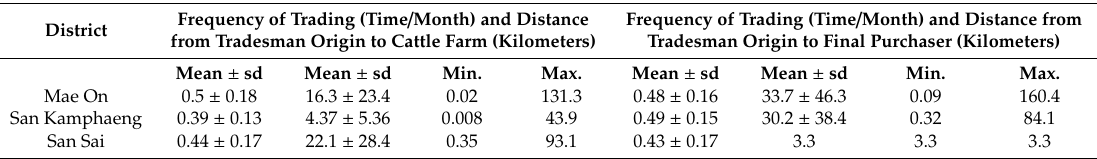
Frequency of Trading (Time / Month) and Distance from Tradesman Origin to Final Purchaser (Kilometers)